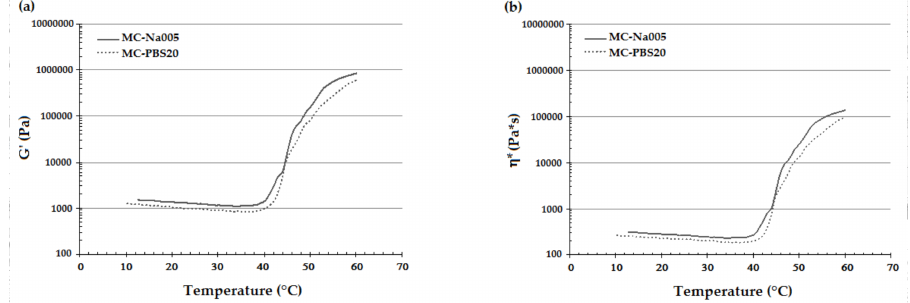
Figure 4. Representative trend of G’ and η * resulting from the temperature sweep tests performed on MC-Na005 and MC-PBS20 hydrogels: ( a ) G’/T curves, ( b ) η */T